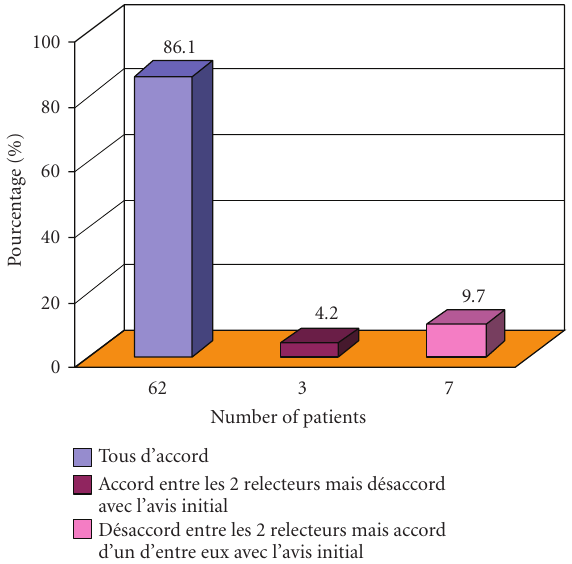
Figure 2: Flow cytometry concordance (Matutes scores).